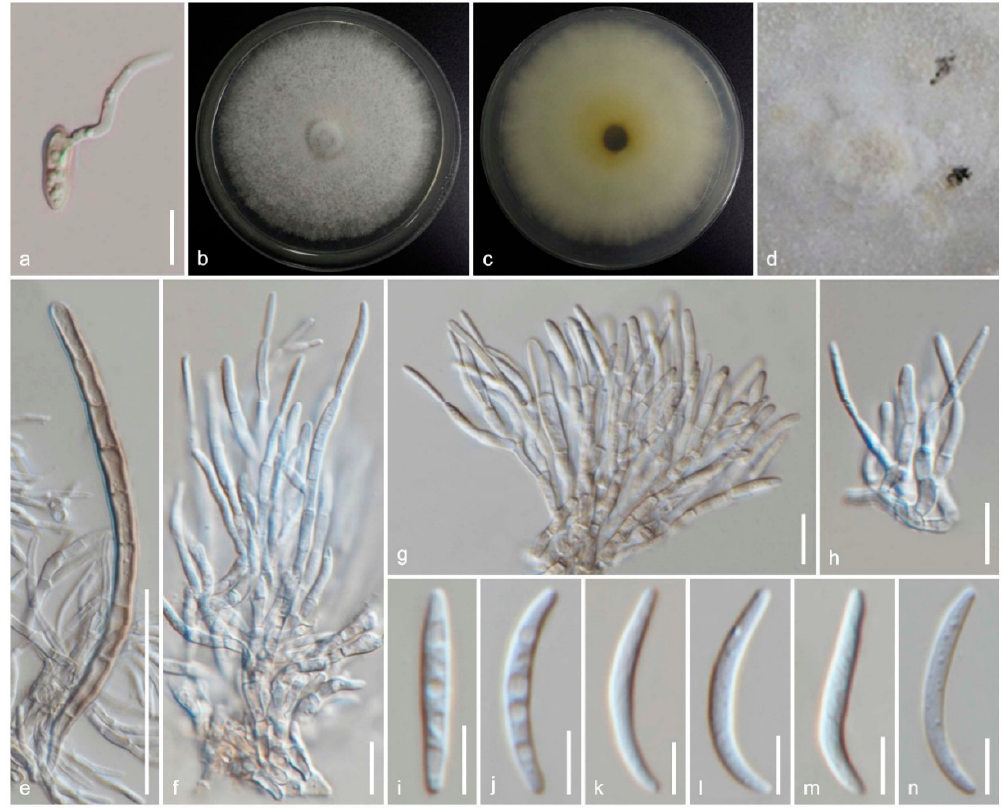
Figure 4. The asexual morph of Amphisphaeria camelliae (MFLUCC 20-0122, ex-type living culture). ( a ) Germinating ascospore; ( b ) upper view, ( c ) reverse view of the 2 weeks old colony on PDA; ( d )